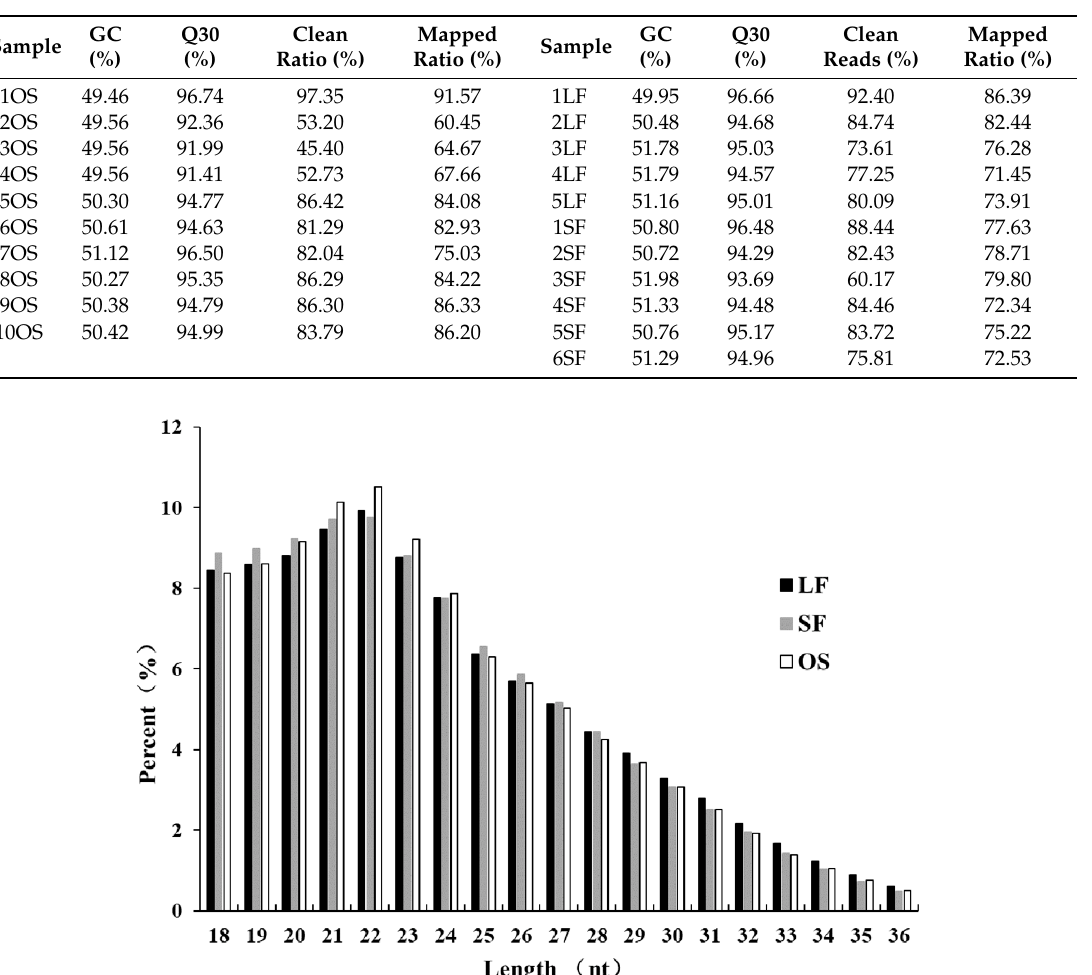
Figure 1. Length distribution of the small RNAs after de-duplication. OS: ovarian stroma; LF: large follicles; SF: small follicles.